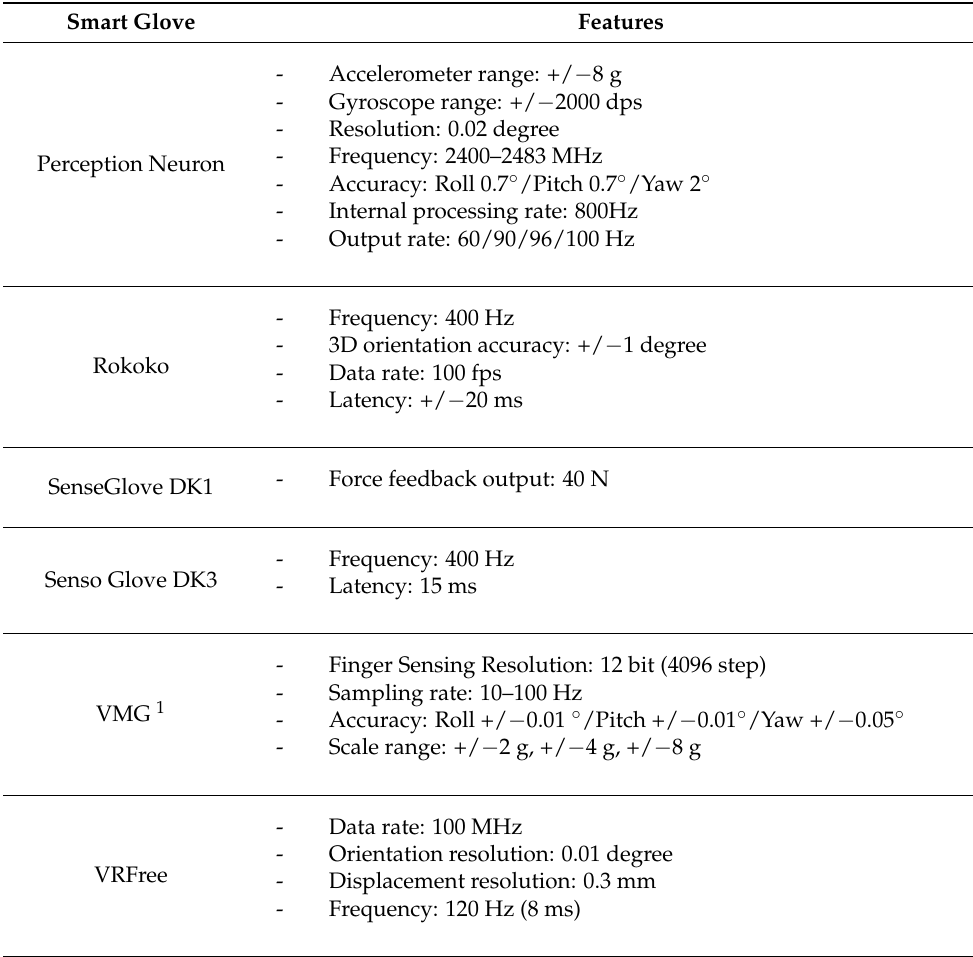
Table 9. Cont. Smart Glove